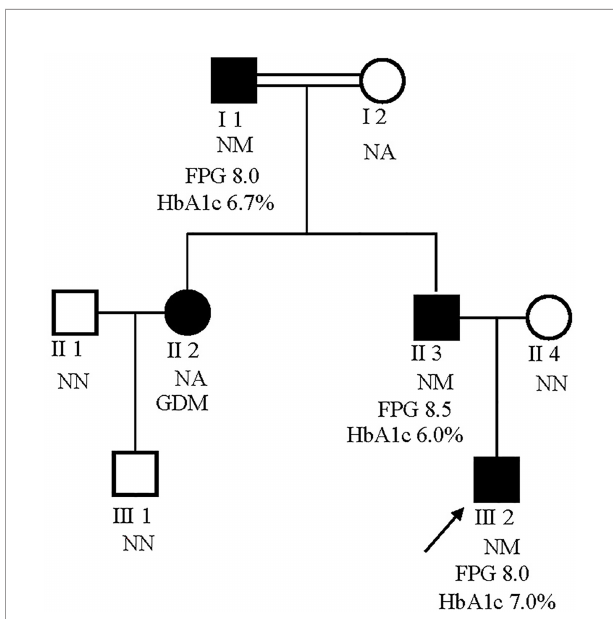
FIGURE 2 | Pedigrees for a MODY2 family showing co-segregation of the Ala259Thr GCK mutation with diagnosed diabetes. Circles represent females, and squares represent males. Black shaded shapes represent diabetic individuals. The number under each member represents the sample identi fi er. NN, no mutation; NM, heterozygous for Ala259Thr mutation; NA, not available for testing. The FPG and HbA1c values are shown where